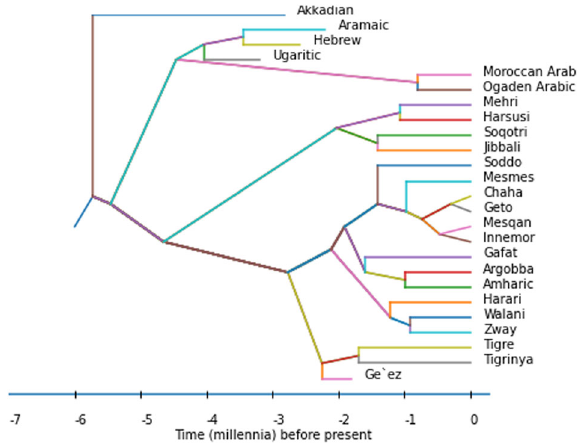
Fig. 8 A phylogenetic depiction of the Semitic Languages. The fi gure is constructed following the results of Kitchen et al. (2009).